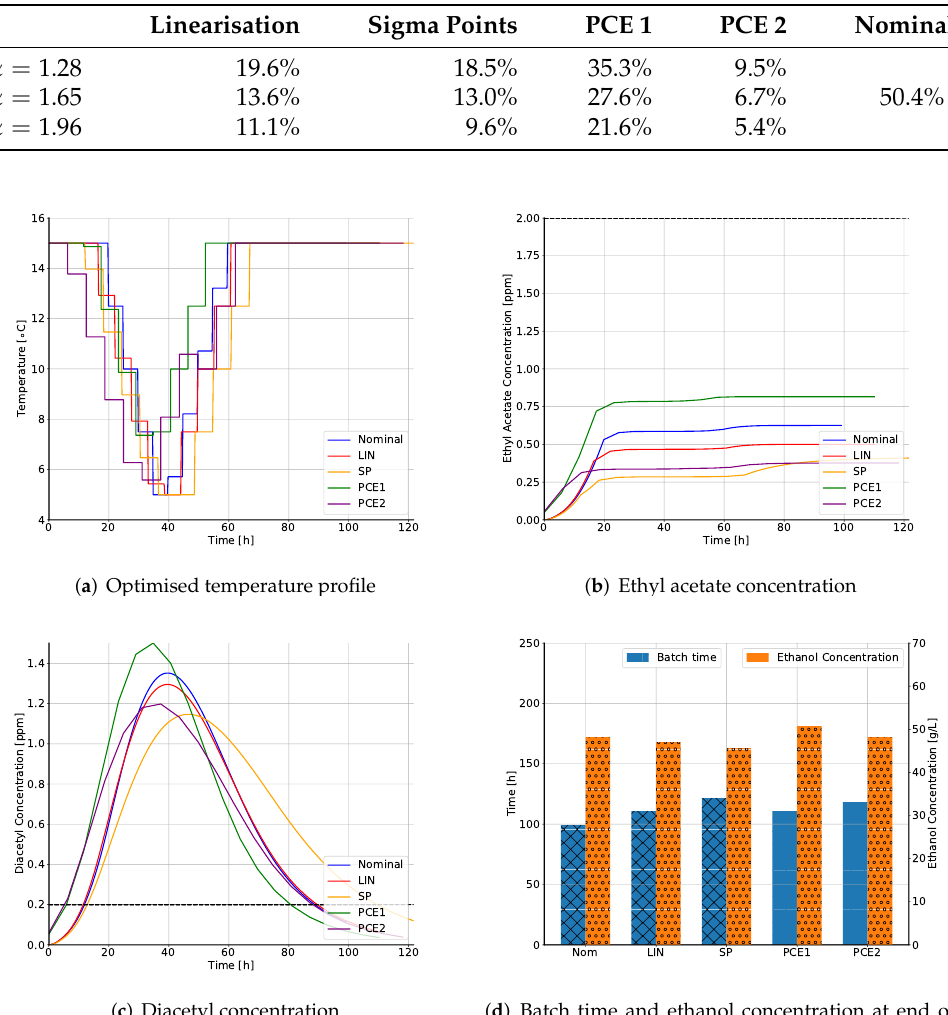
Figure 6. Optimisation results for minimising time with all three methods and α = 1.65. The concentration trajectories depicted were obtained by applying the optimised temperature trajectory to the model with nominal